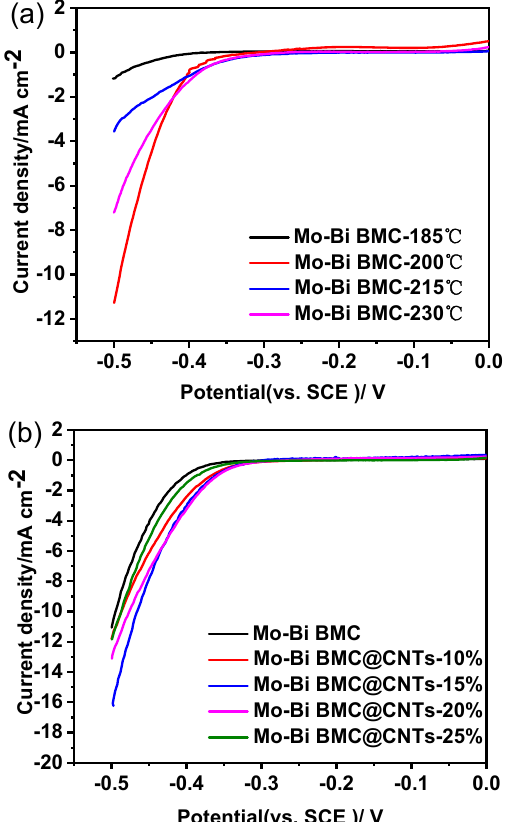
Figure 6. Linear sweep voltammetry of the Mo–Bi BMC ( a ) and Mo–Bi BMC@CNTs ( b ).